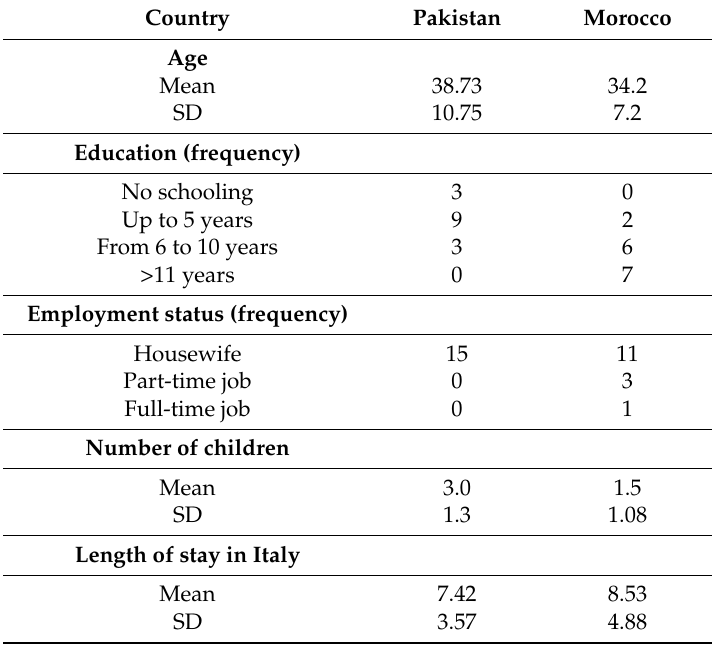
Table 1. Socio-demographic